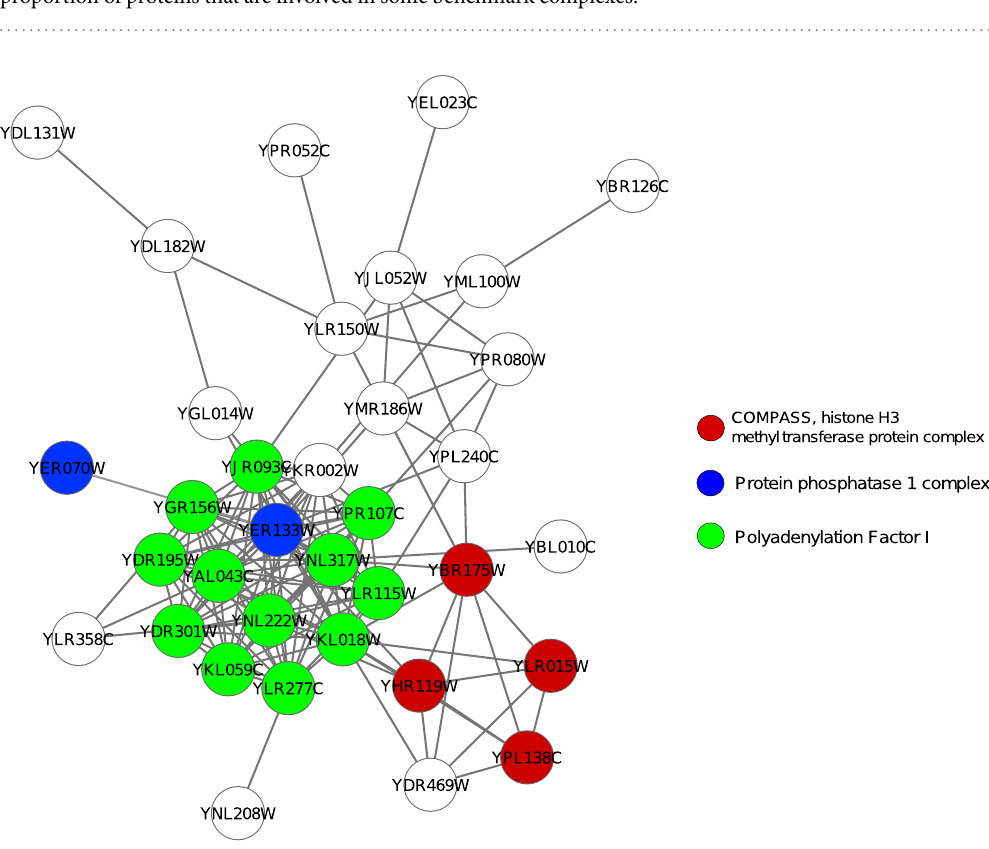
Figure 9. Top rank predicted complex, involved in three different benchmark complexes. Red, green and blue nodes are involved in the subunit of three benchmark complexes: COMPASS, histone H3 methyltransferase protein complex, Protein phosphatase 1 complex, and Polyadenylation Factor I respectively. White nodes are not assigned in any